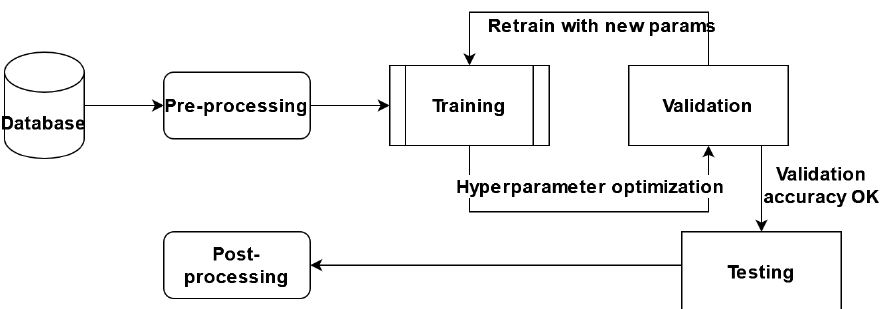
Figure 6. Components of the System: database (BraTS 2020), pre-processing, training, validation, testing, and